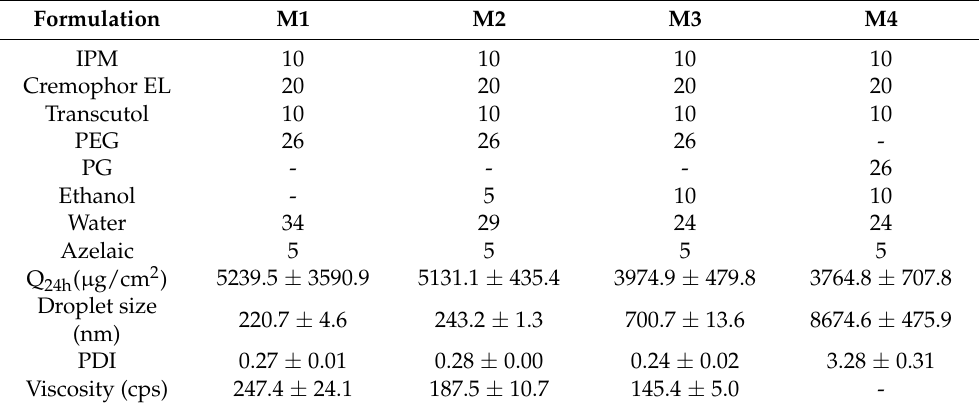
Table 1. The composition, cumulative amount and mean droplet size of azelaic acid-loaded formulations. Formulation M1